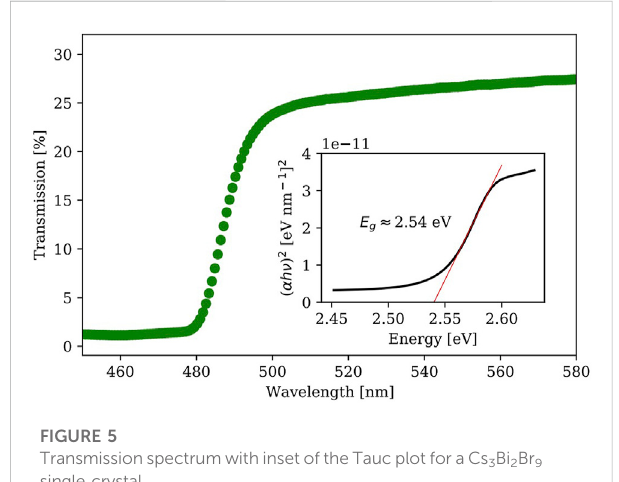
FIGURE 5 Transmissionspectrumwith insetoftheTaucplotfor aCs 3 Bi 2 Br 9 single